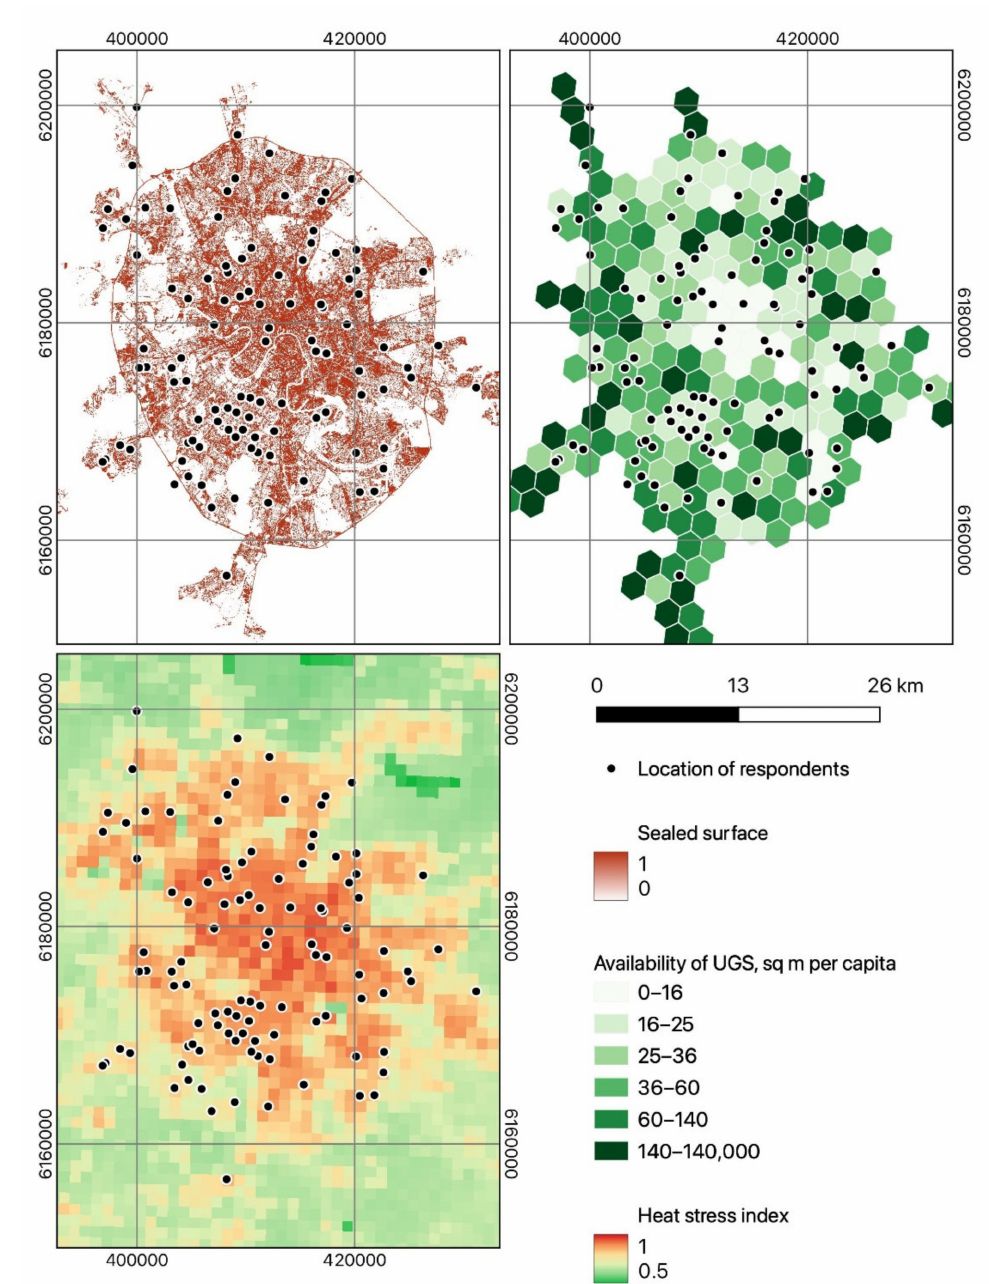
Figure 16. Location of survey respondents ( top left ), UGS availability ( top right ), and the heat stress index ( bottom left ) in